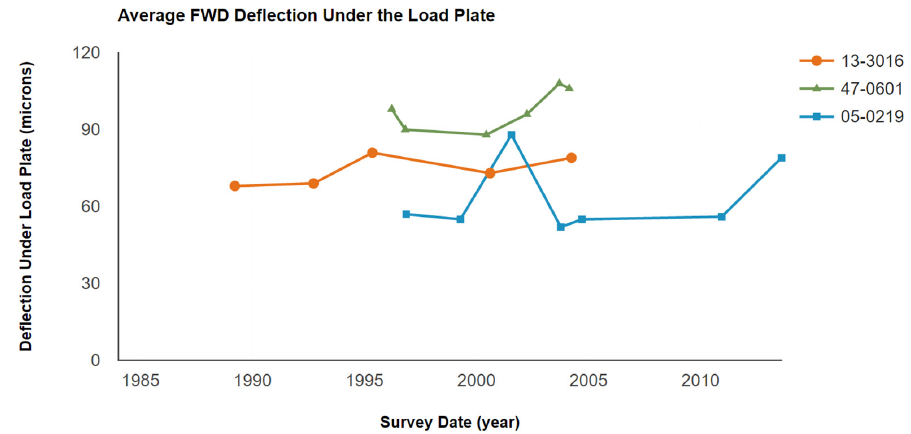
Figure 8. Average FWD deflection.